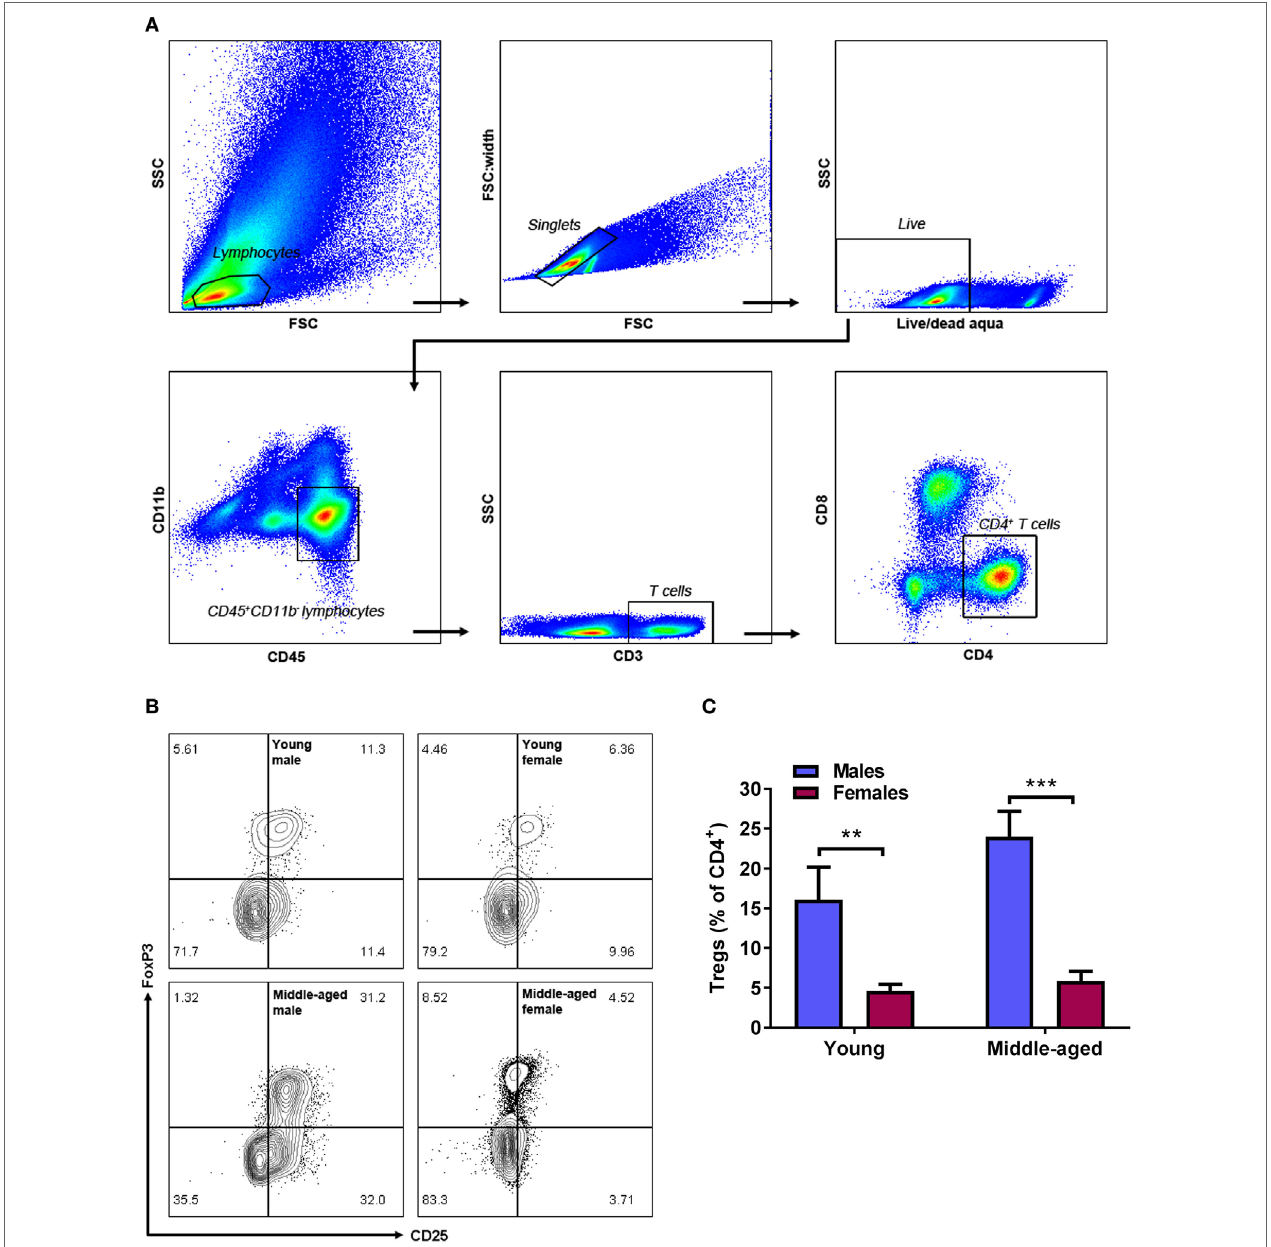
FigUre 4 | Males have higher levels of adipose regulatory T cells (Tregs) compared to age-matched females. Gating strategy (a) , representative contour plots (B) , and quantification (c) of CD4 + CD25 + FoxP3 + Tregs in adipose tissue from young and middle-aged male and female mice. Two-way ANOVA effect of sex: p < 0.001, ** p < 0.01, *** p < 0.001 Sidak’s multiple comparison’s test, n =